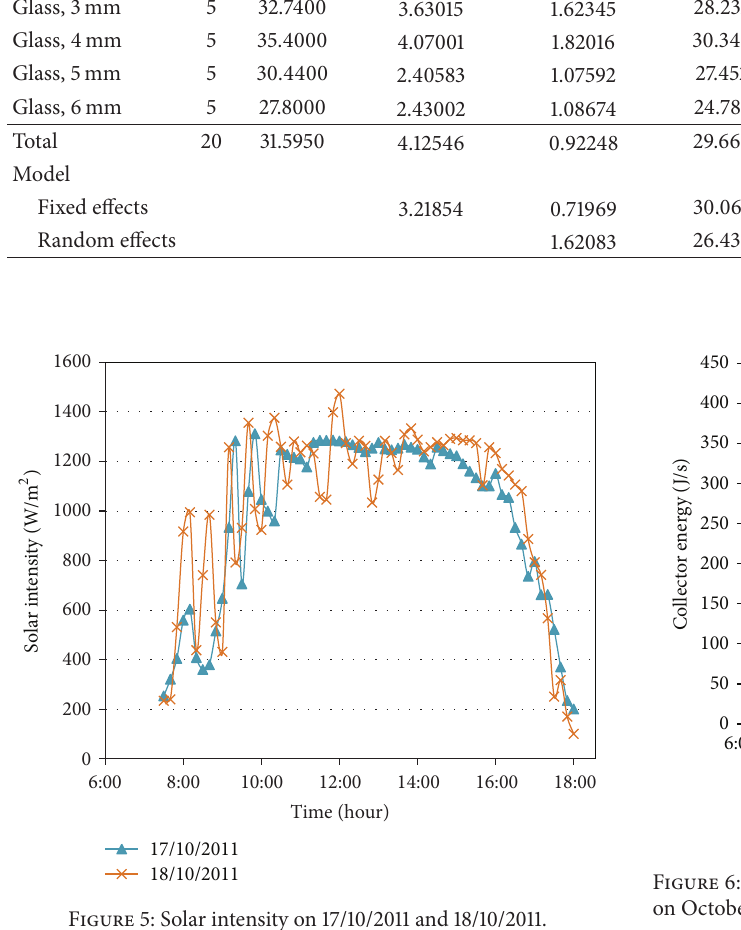
Figure 5: Solar intensity on 17/10/2011 and 18/10/2011.